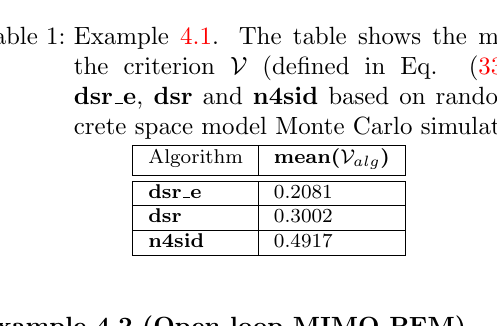
Table 2 (rows 2:3, column 2) that the dsr e algorithm